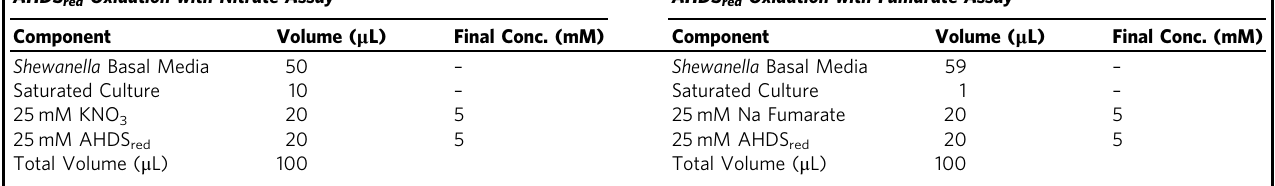
Table 1 Solution mixing instructions for AHDS red oxidation assay for each well in a 96-well plate. AHDS red Oxidation with Nitrate Assay AHDS red Oxidation with Fumarate Assay